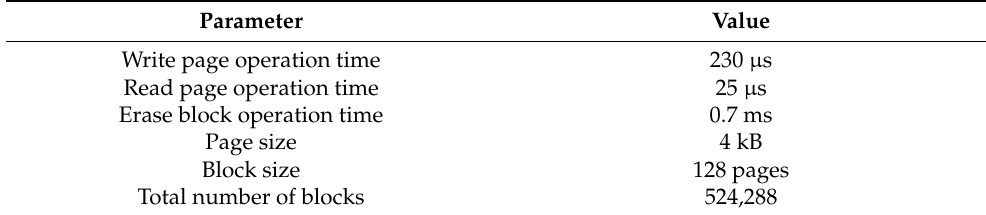
Table 2. Parameters of the NAND flash